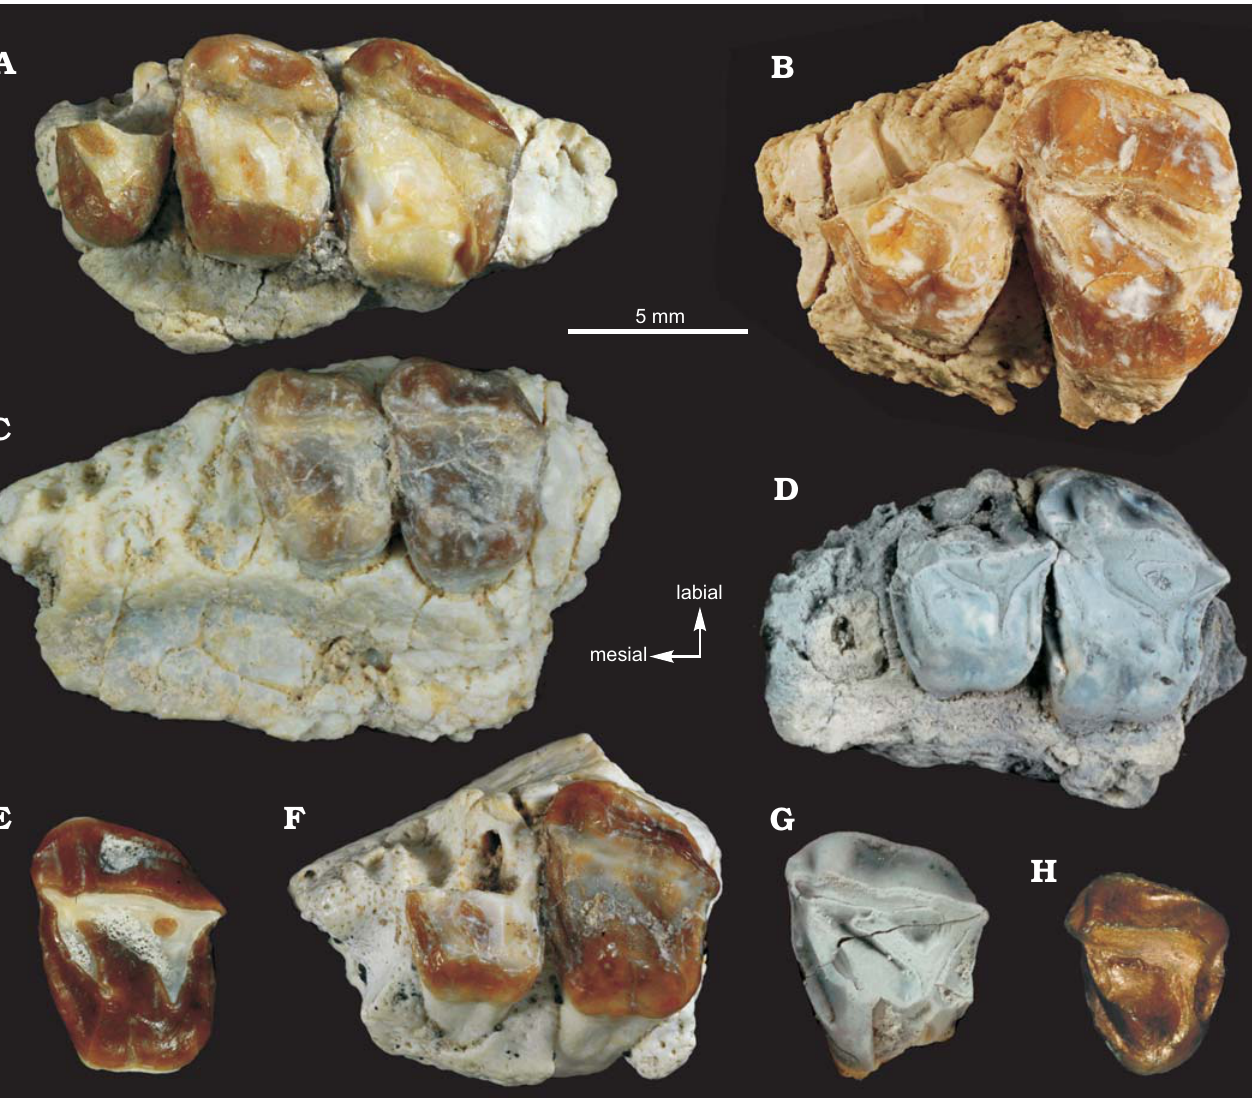
Fig. 4. Notoungulate mammal Orome deepi gen. et sp. nov. from the early Eocene of Las Violetas Farm (A–C) and Las Flores (D–H), Argentina, all tooth in occlusal view. A . MLP-90-II-5-1633, fragment of right maxilla with M1–M2. B . MLP-90-II-5-1632, fragment of left maxilla with M1–M2. C . MLP- 90-II-5-1634, fragment of right maxilla with M1–M2. D . MLP-90-II-5-1637, fragment of left maxilla with broken P4, M1, and M2. E . MLP-90-II-5-1636, isolated left M1. F . MLP-90-II-5-1638, fragment of left maxilla with broken M1 and M2. G . MLP-90-II-5-1635, isolated left M1. H . MLP-79-I-5-47, isolated right M3. A, B, C, and H were horizontaly